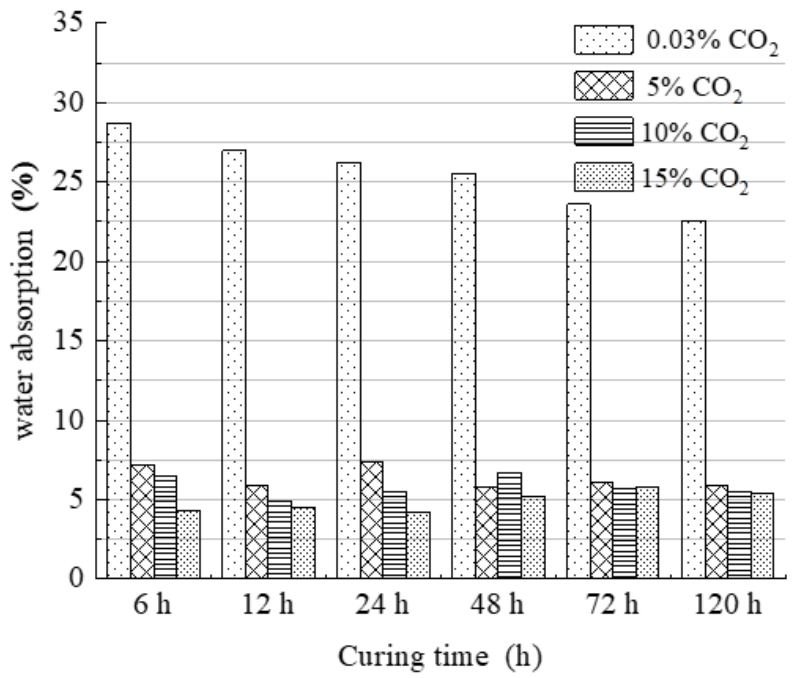
Figure 5. Curing time on the water absorption of the